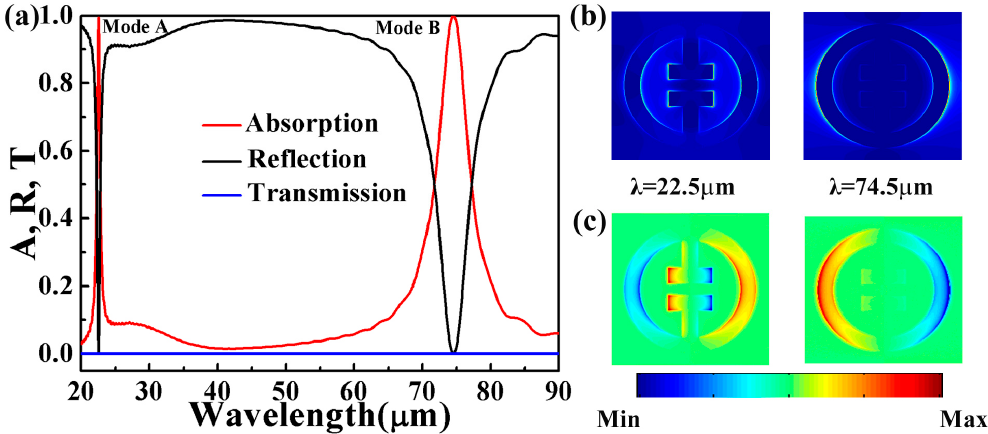
Figure 2. ( a ) Absorption (A), reflective (R), and transmission (T) spectrum of the presented structure; ( b , c ) are the electric field distribution of the corresponding graphene and the simulated surface charge density distributions at λ 1 = 22.5 µ m and λ 2 = 74.5 µ m, respectively.